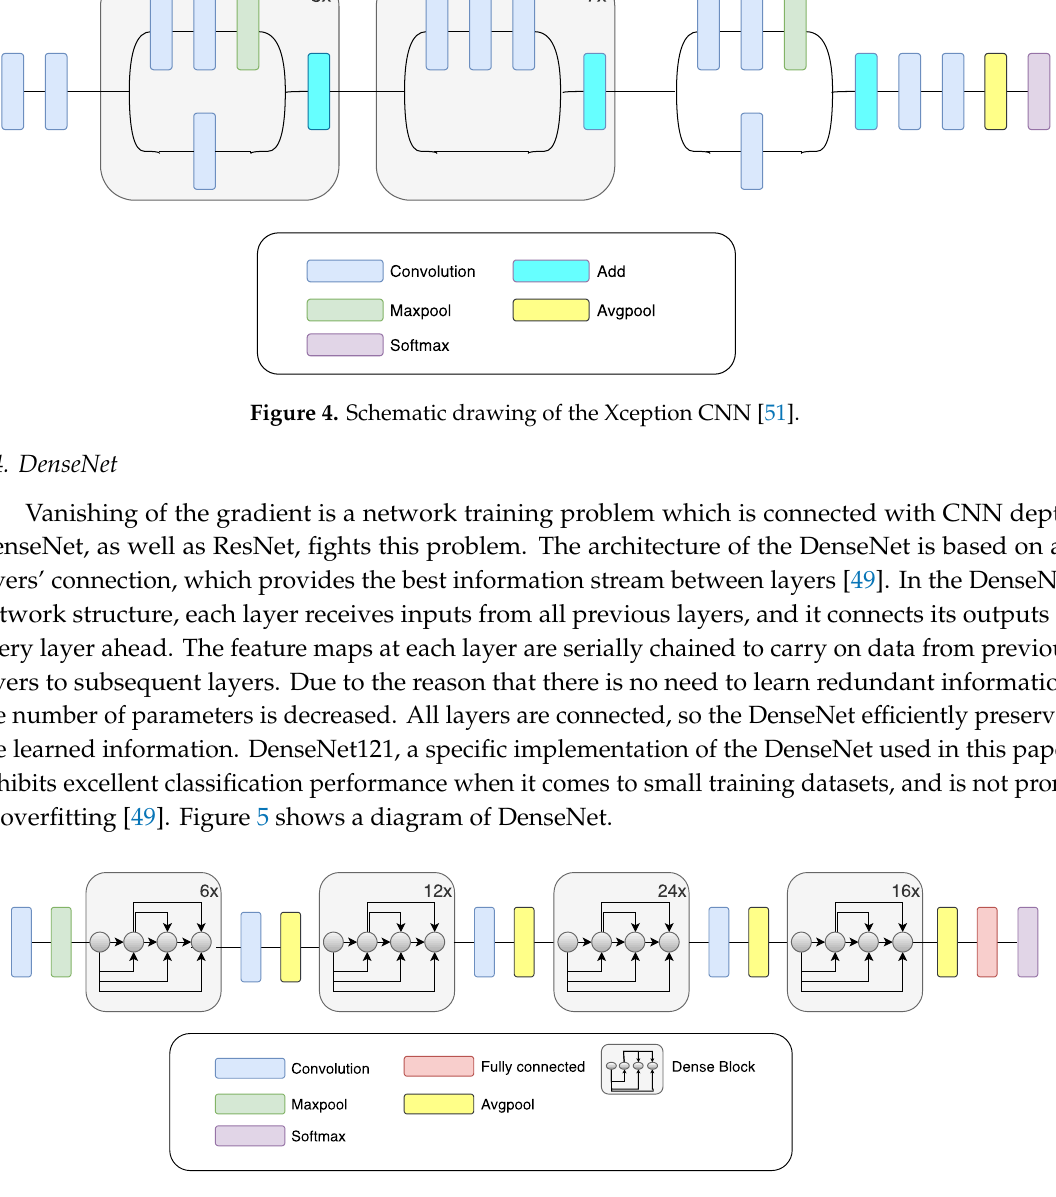
Figure 5. Schematic drawing of the DenseNet CNN [51].